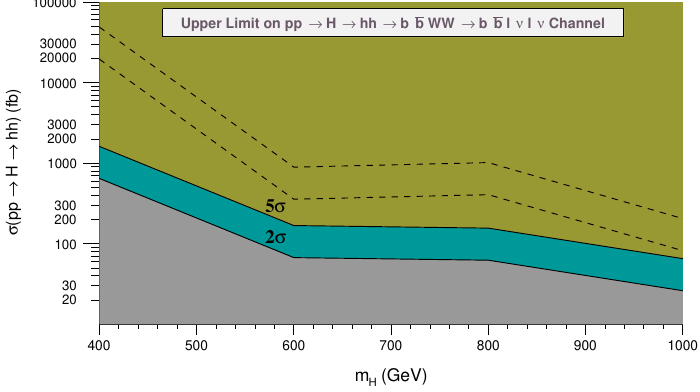
Figure 20 . Upper limit on (cid:27) ( pp channel. The solid (dashed) lines show the 2 (cid:27) -5 (cid:27) band on taking 0% (5%) systematic